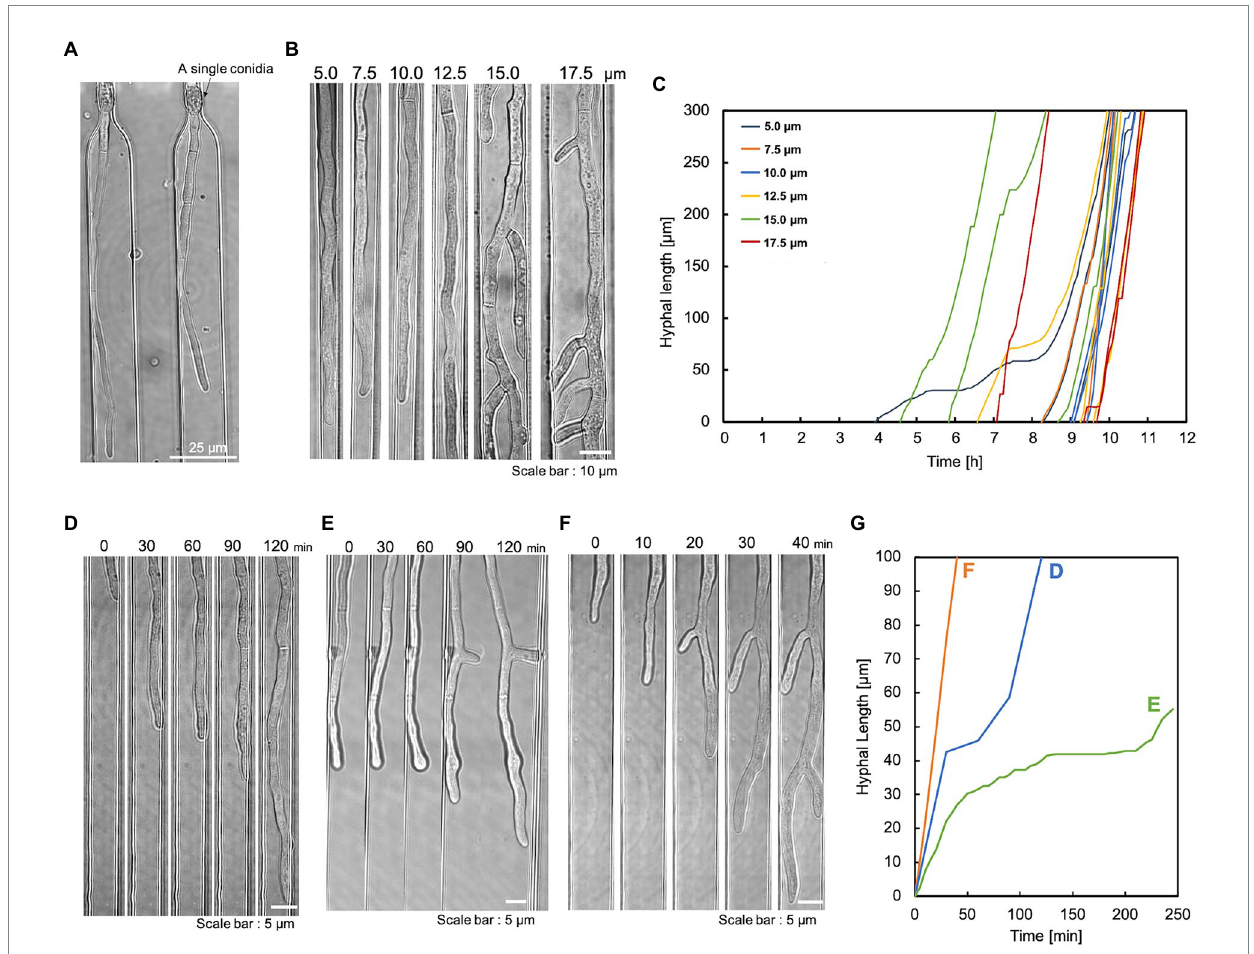
FIGURE 2 Single conidia trapping and compartmentalized hyphal growth. The hyphae were cultivated under a constant flow of 1% glucose in the basic medium at 0.5 mL/h. (A) A single conidium of T . reesei was trapped at the conidia trapping site. Scale bar: 25 μ m. (B) The compartmentalized hyphal extension of T . reesei along the hyphal growth channels. Observation at 11 h. Scale bar: 10 μ m. (C) Time course of three individual hyphal length elongations per channel width on a single device. The hyphal length was measured at regular intervals of 5 min starting after conidia trapping. (D) Delayed elongation without branching. Scale bar: 5 μ m. (E) Delayed elongation with branching. Scale bar: 5 μ m. (F) Hypha that did not delay elongation with branching. Scale bar: 5 μ m. (G) Quantification of hyphal elongation in (D–F)